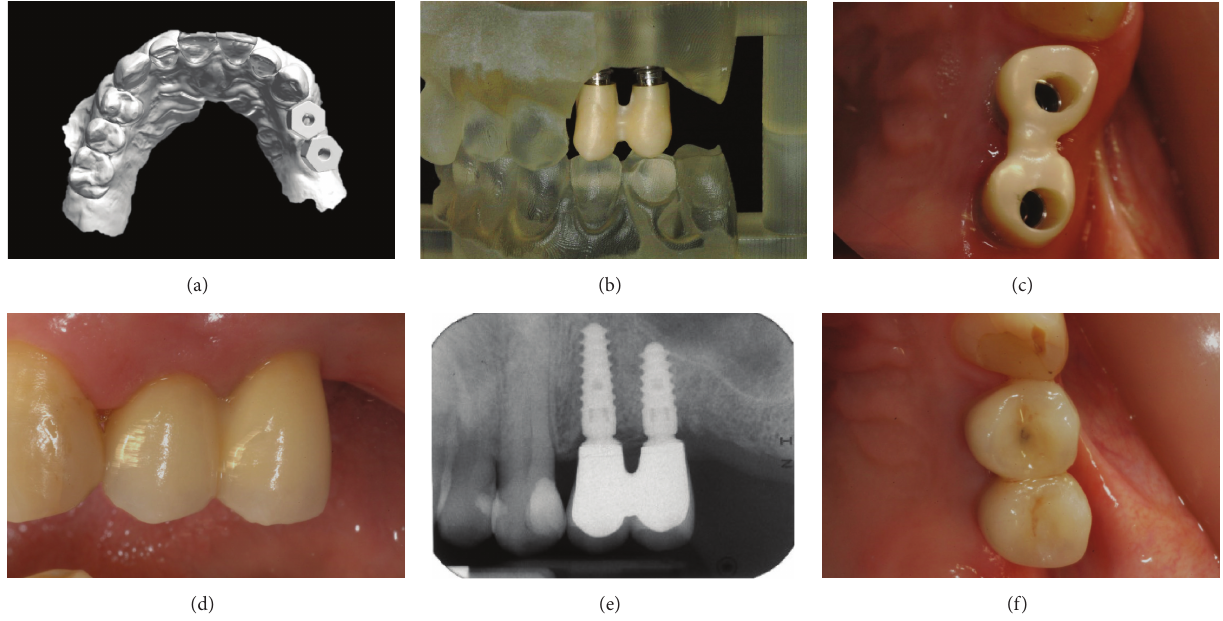
Figure 4: Three months after implant placement, the definitive intraoral impression is taken, and the definitive implant-supported restoration is fabricated and delivered to the patient: (a) digital impression with PEEK scanbodies; (b) the 3D-printed model with the zirconia framework; (c) the zirconia framework is seated on the definitive titanium abutments and checked for accuracy/precision (occlusal view); (d) delivery of the final zirconia-ceramic restoration, cemented on the final titanium abutments (side view); (e) periapical radiograph at the delivery of the final implant-supported restoration; (f) 6-month control of the final zirconia-ceramic restoration (occlusal